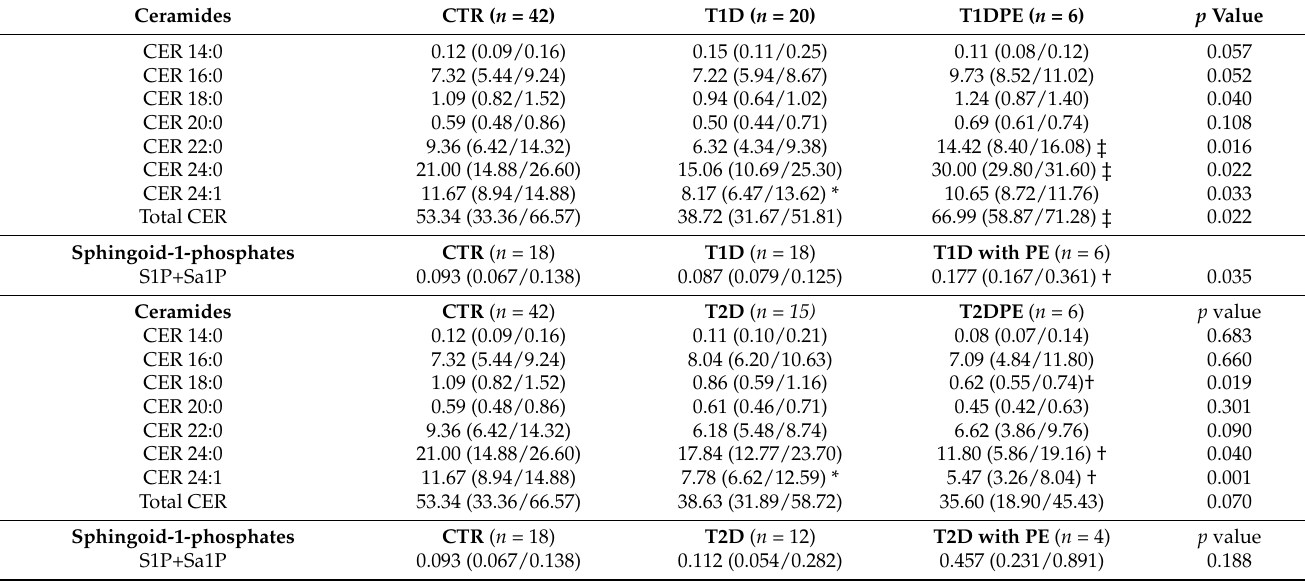
Table 2. Placental sphingolipids in maternal pre-existing diabetes with and without